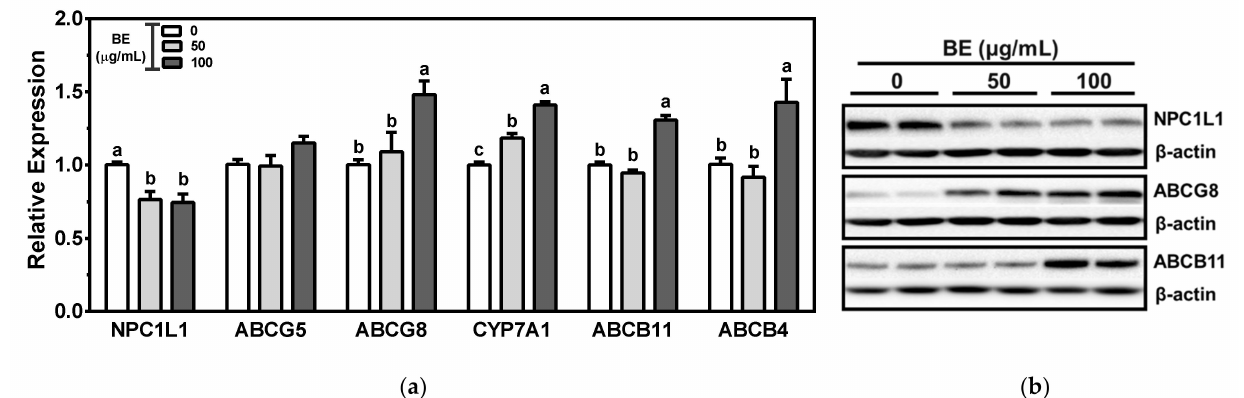
Figure 4. The effect of BE on the genes regulating biliary cholesterol efflux in HepG2 cells. The cells were treated with either 50 or 100 µ g/mL of BE for 24 h. ( a ) The mRNA abundance was determined by qRT-PCR analysis. Bars with different letters are significantly different ( p < 0.05). Values are means ± S.E.M. n = 6. ( b ) The representative image of the Western blot is shown. β -actin served as a loading control.